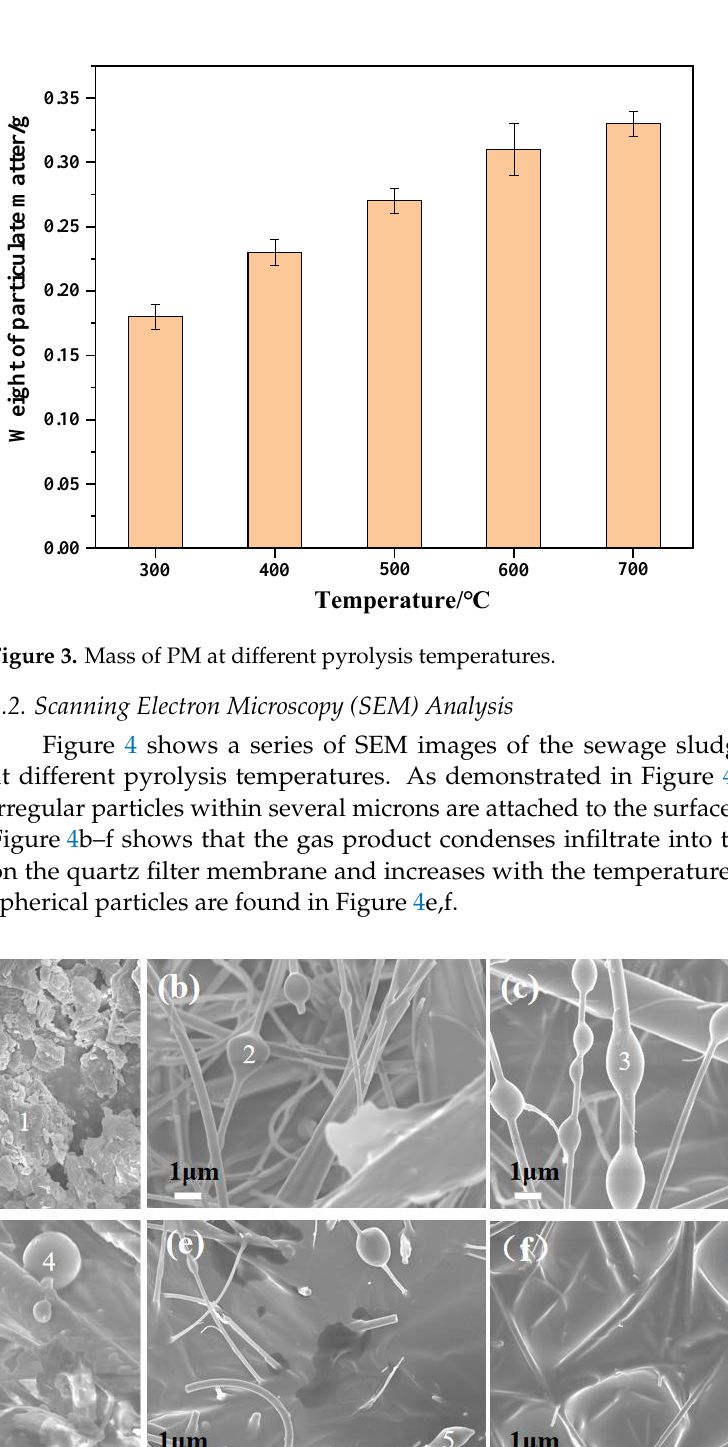
Figure 4. SEM images of PM collected with different temperatures. ( a ) SS, ( b ) PM-300, ( c ) PM-400, ( d ) PM-500, ( e ) PM-600, ( f ) PM-700. SS, sewage sludge. PM-X, PM derived from sewage sludge pyrolysis at X (°C) temperature.